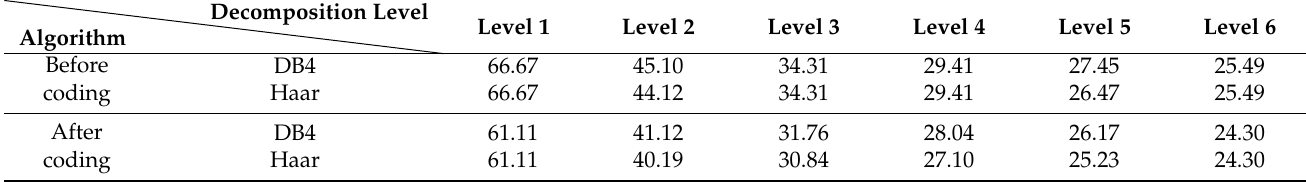
Table 2. Measured gas data compression ratio performance (%).